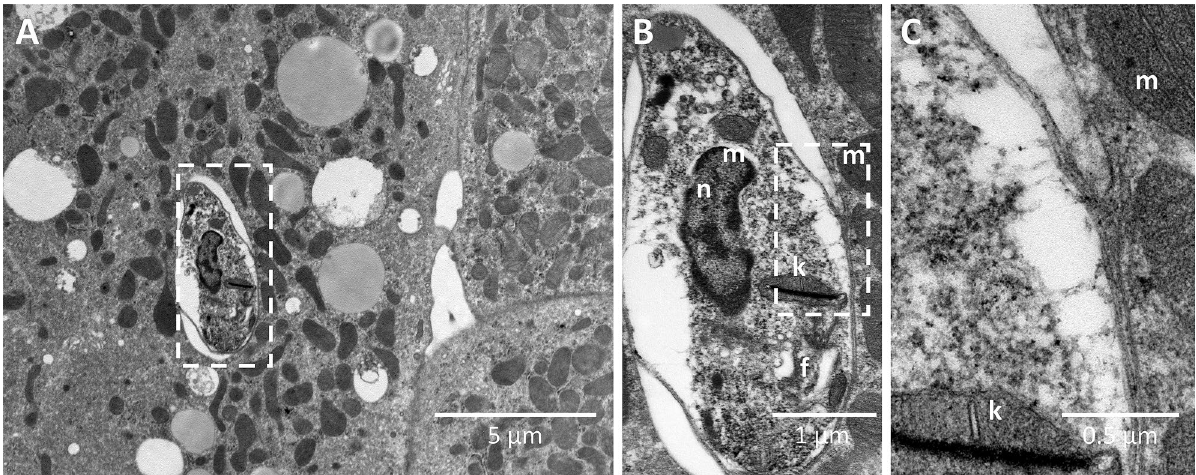
Figure 5. ( A–C ) Electron microscopy of in vitro infected brown adipocytes by GFP- L. infantum with different magnification (nucleus (n), flagella (f), kinetoplast (k), mitochondrion